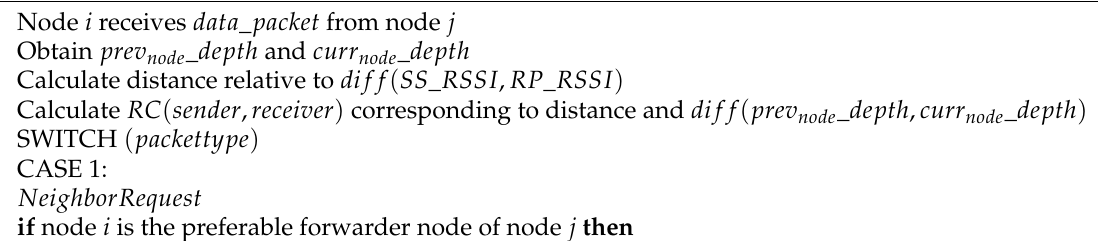
Algorithm 1 Algorithm for forwarding data